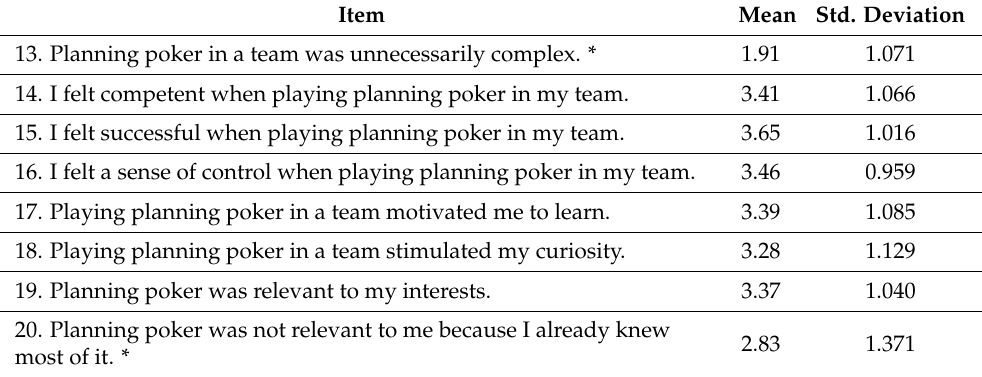
Item Mean Std. Deviation